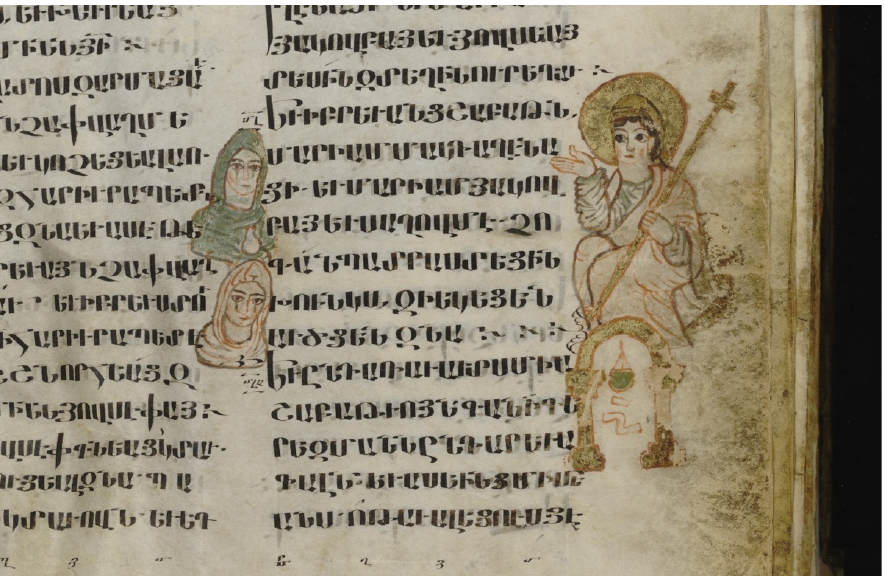
Figure 4. arm 724 f. 110r Copyrights: Cod. 2374 Matenadaran the Research Institute of Ancient Man-